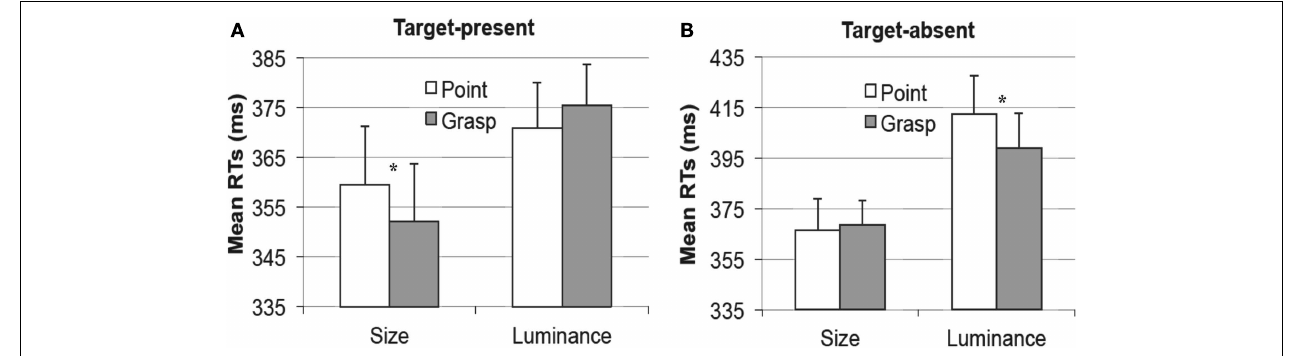
dimension are depicted on the left of (A,B) and for the luminance dimension [ (A,B) right]. Error bars represent standard errors adjusted to within-subject designs, calculated according to the procedure described in Cousineau